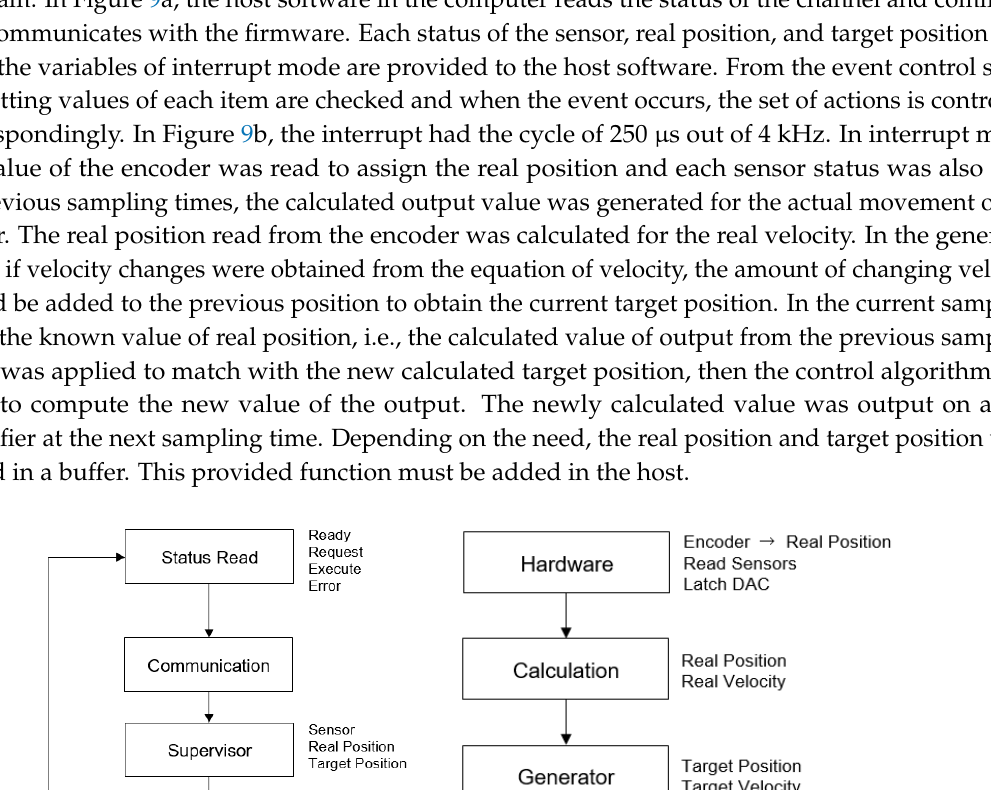
( b ) Figure 10. The pan-tilt mechanism for the digital camera: ( a ) theoretical design, and ( b ) 3D design.